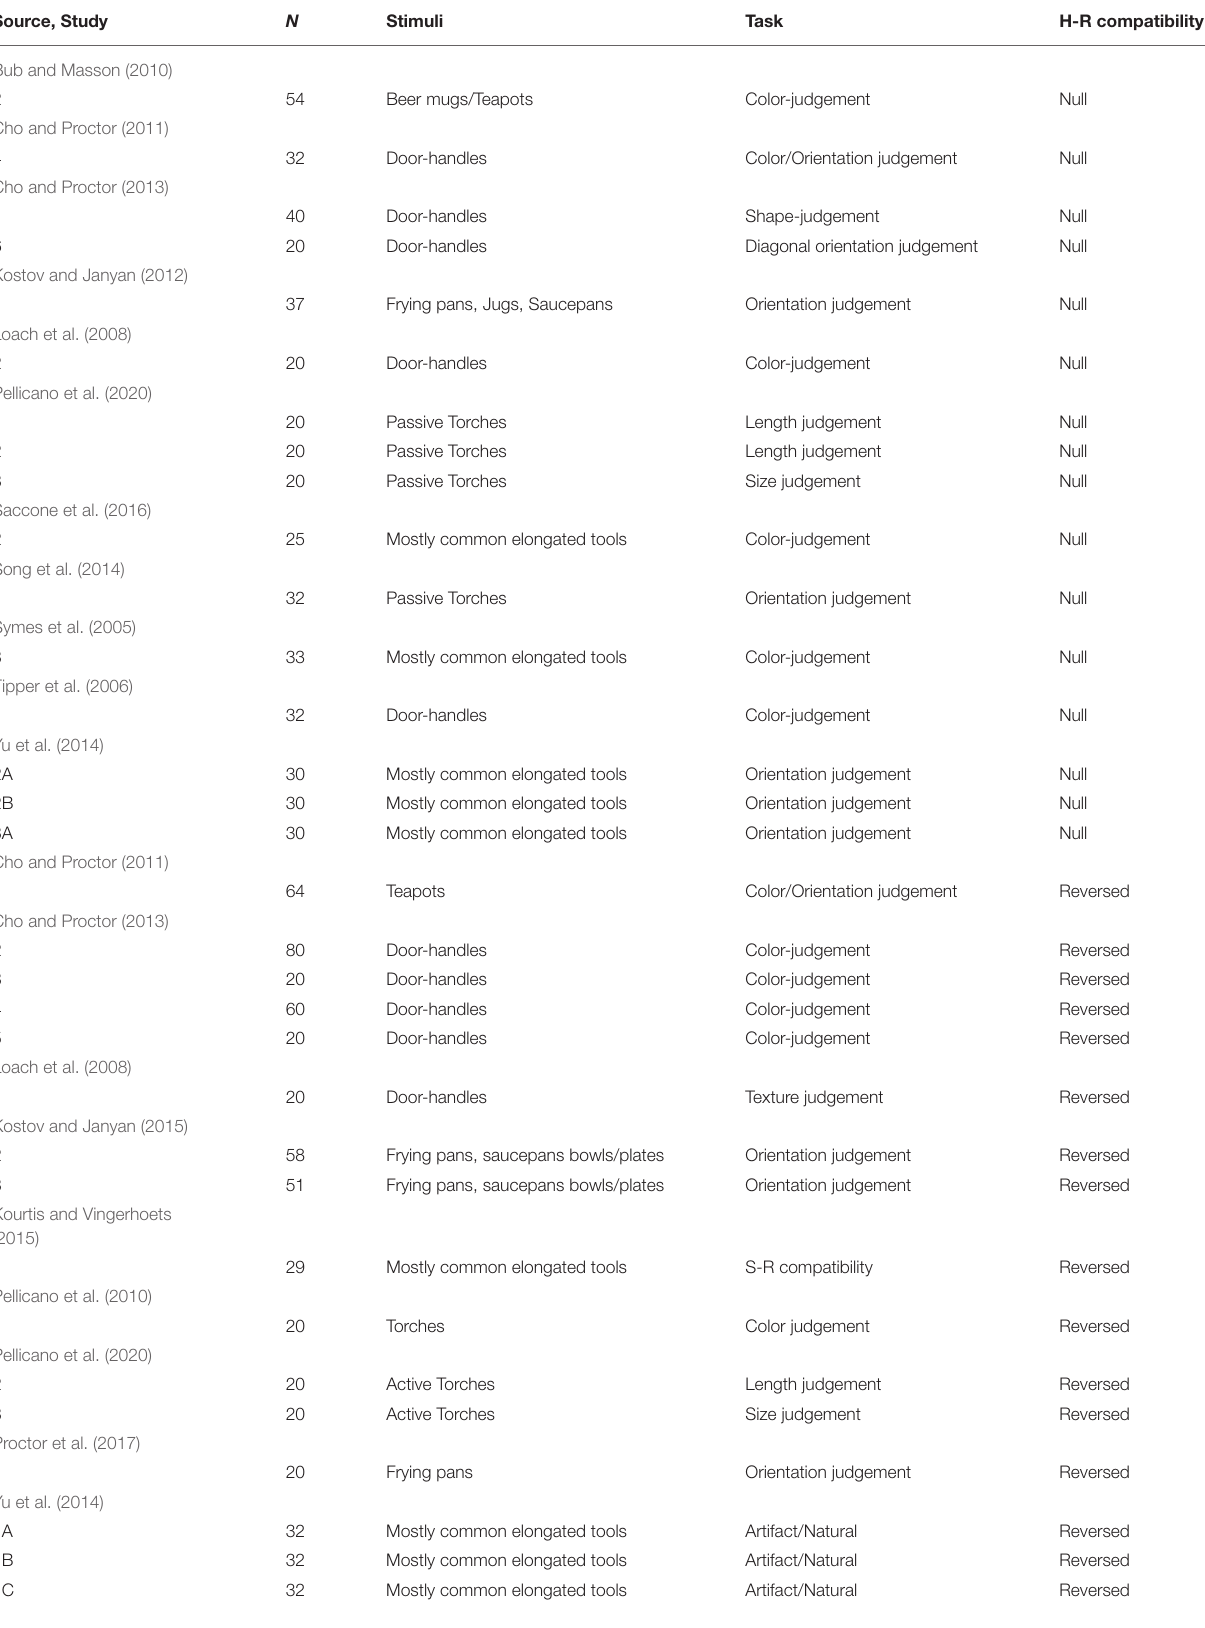
TABLE 1 | Prior known tests of the Handle–Response (H–R) compatibility effect showing null and/or reversed effects. Source,